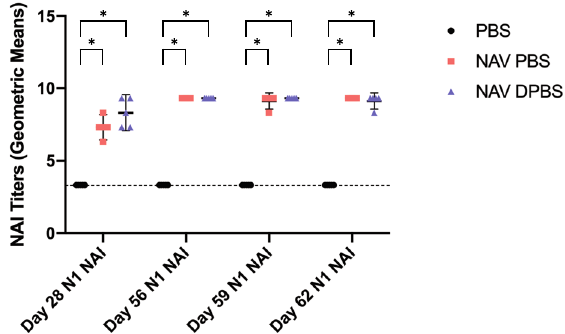
Fig. 5 Immunogenicity of NAV PBS and NAV DPBS as assessed by NAI titers against N1. Mice were vaccinated with NAV in PBS (red squares), NAV in DPBS (blue triangles), and PBS control (black circles) on days 0 and 28 and challenged with 10 5 TCID 50 A/Bethesda/MM2/ 2009 (H1N1) on day 56. Blood was collected on days 28, 56, 59, and 62 for assessment of NAI titers against N1 ( n = 5 mice per condition per time point except n = 10 on day 56). Points represent log 2 geometric means of individual mice and error bars represent means and standard deviations. Dotted line represents minimal limit of detection. ANOVA and post-hoc Tukey test were performed where * p < 0.0001.